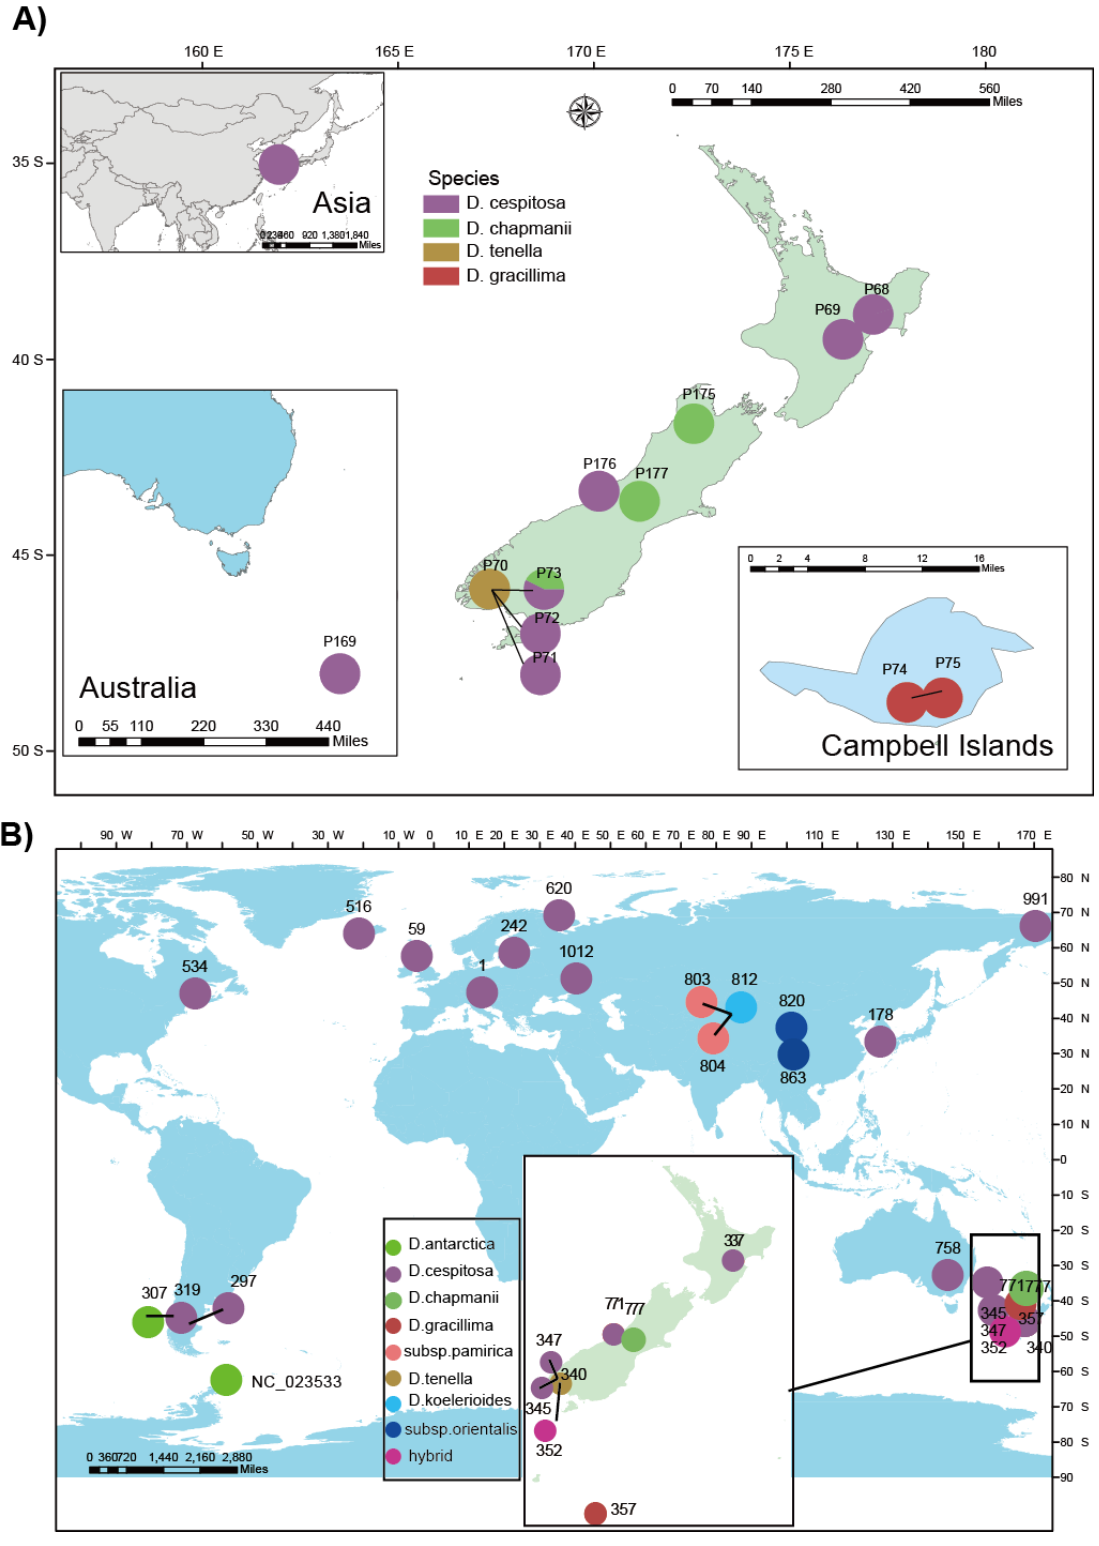
Figure 1. Sampling map for Deschampsia localities investigated in this study. ( A ) Sampling for RAD analysis; ( B ) Sampling for plastid genome analysis. Different species are highlighted with different colors. In map ( A ), populations of Korea, Australia and Campbell Islands are shown in inserted small maps. The coordinates of each population are given in Supplementary Materials (Table S1). The map data were downloaded from the open-access website: diva-gis.org.